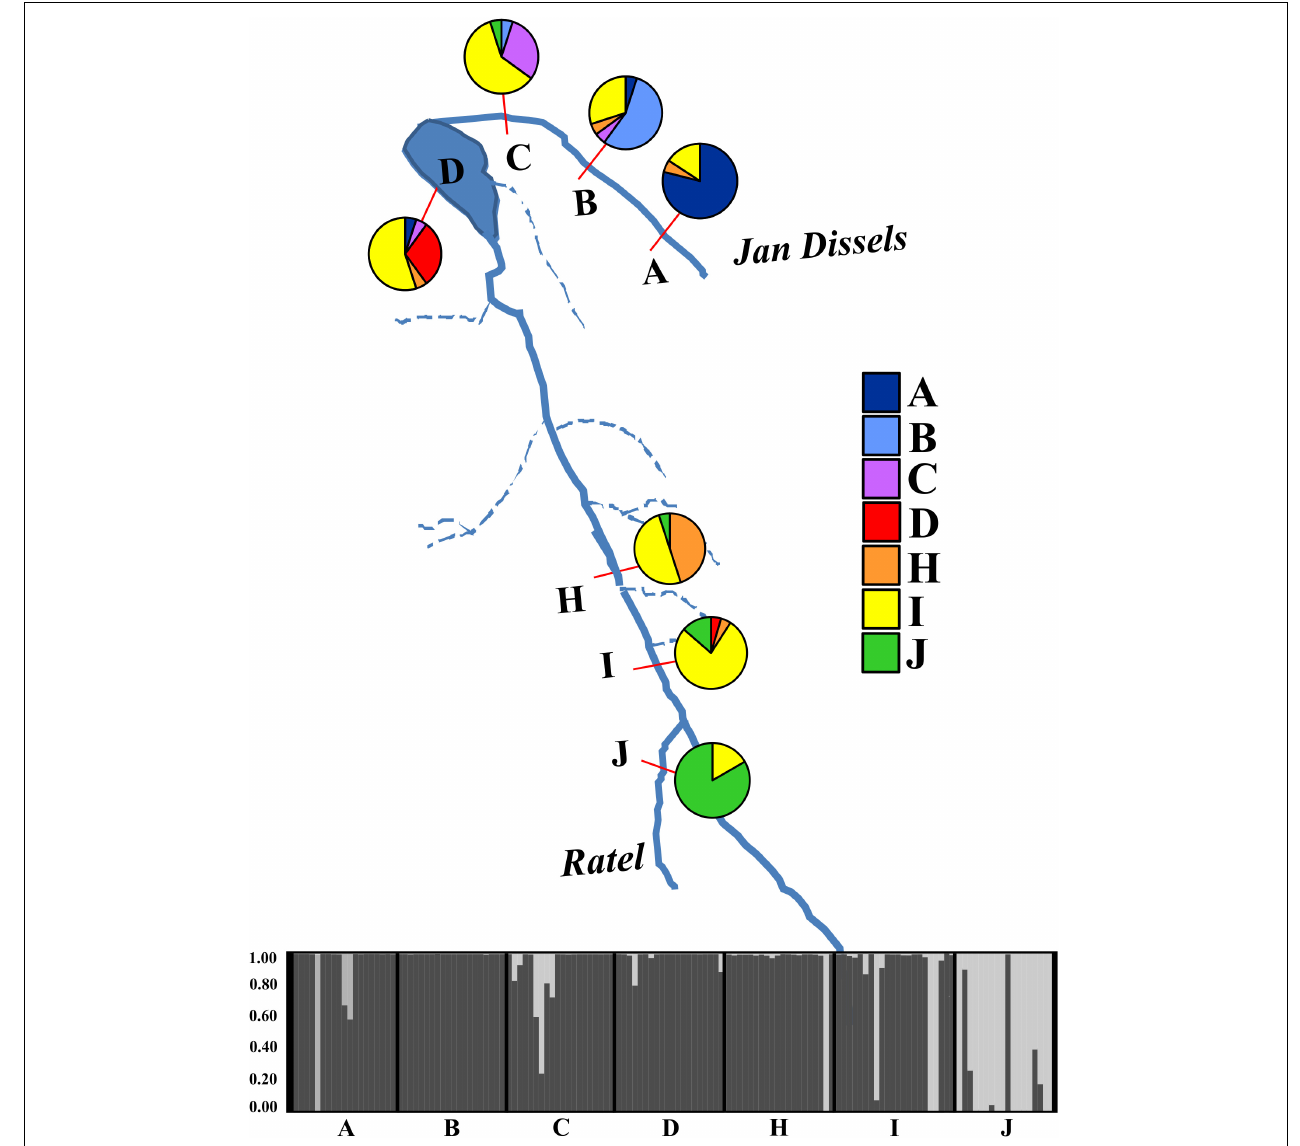
FIGURE 5 | A graphical representation of the seven sampled localities used in the genetic analyses (A – D, H – J). The percentage correctly assigned individuals, obtained from GENECLASS 2.0, for each sampled locality is depicted with a pie chart, with colors corresponding to those in the legend on the right. The STRUCTURE plot represents all seven sampled localities, with each line in the plot corresponding to an individual within that sampled locality. Colors represent the proportion of an individual’s genotype assigned to a given genetic cluster ( K = 2).